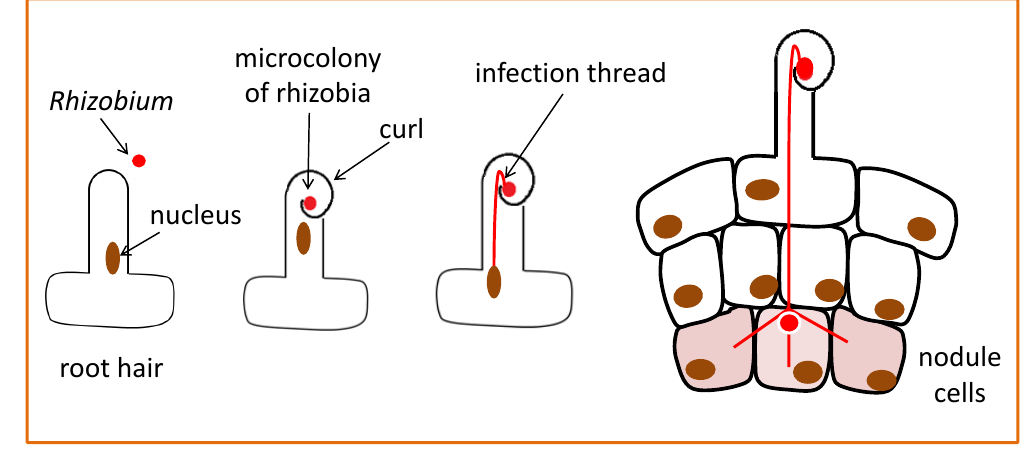
Figure 1. Diagram of the response of a Medicago truncatula legume root to nitrogen-fixing rhizobia. After exposure to rhizobial signals (Nod factors) the legume root hair curls to entrap the bacteria, which then penetrate into the root via a plant-made infection thread. Branches of the infection thread penetrate cortical cells, which proliferate, leading to the formation of a root nodule to house the bacteria. Nodule formation takes place over the course of several days, while imaging is usually done only for a few hours after root hairs’ exposure to Nod factors. Ca 2 + signals have been linked to the infection thread growth and nodule formation by analysis of different mutants. The brown oval denotes the nucleus, which moves to guide the formation of the infection thread [3,4]. The nucleus is anchored by cytoplasmic strands that connect it to the cytoplasm (not represented; it presents different cytoarchitecture according to the root hair development